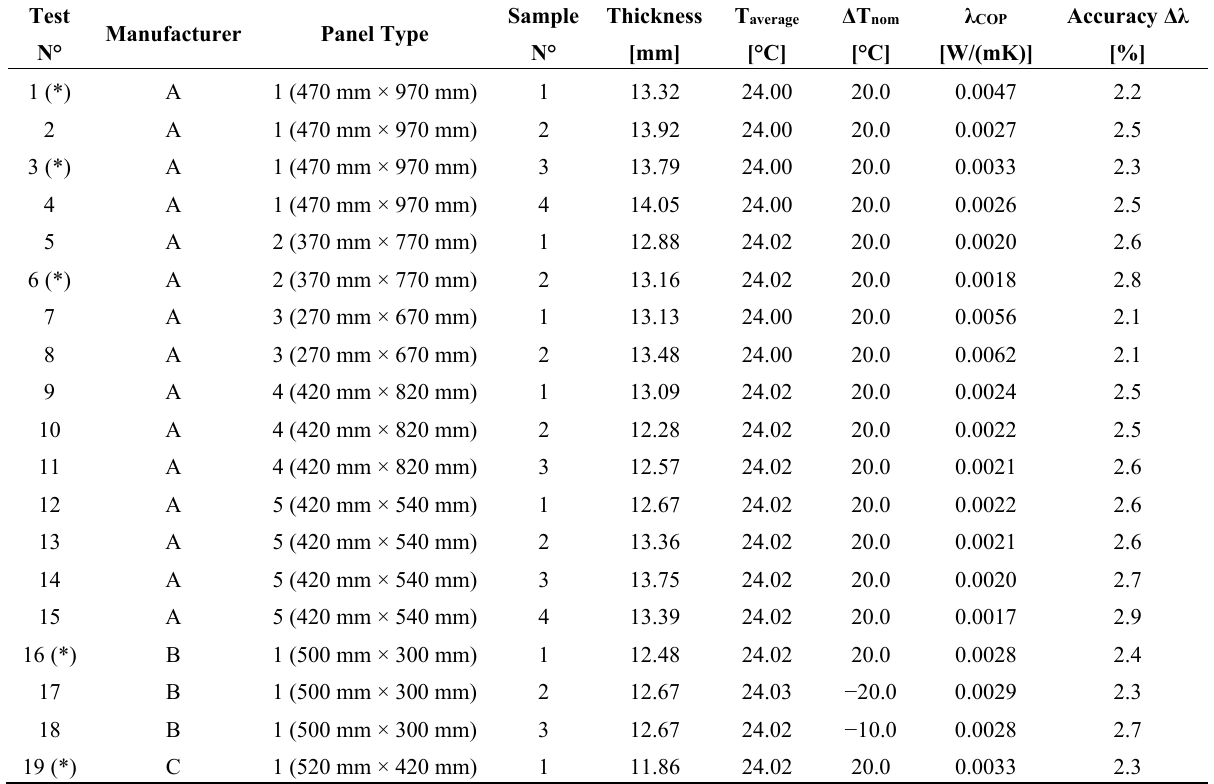
Table 1. Features of the tested VIP panels and λ COP measurement